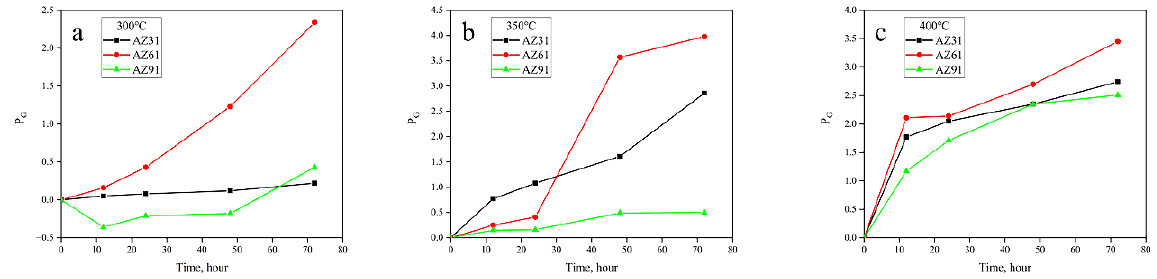
Figure 6. P G of AZ31, AZ61, and AZ91 annealed at ( a ) 300 °C, ( b ) 350 °C, and ( c ) 400 °C. The microstructures evolutions of AZ31, AZ61 alloys during annealing at 450 ◦ C are shown in Figure 7. It can be seen that the microstructure of AZ31 at 450 ◦ C is relatively homogeneous, and the number of fine recrystallized grains is reduced. However, the grain growth of AZ61 alloy is dominated by AGG at increasing temperatures. This indicates that the dissolution of the second phase particles increases the driving force of grain